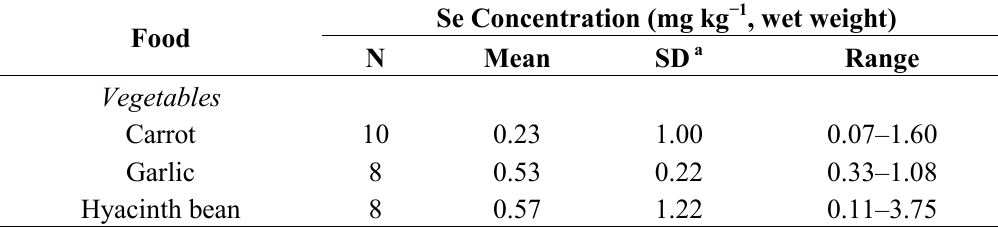
Table 3. Concentrations of selenium in foods grown in Shadi, Enshi, China.